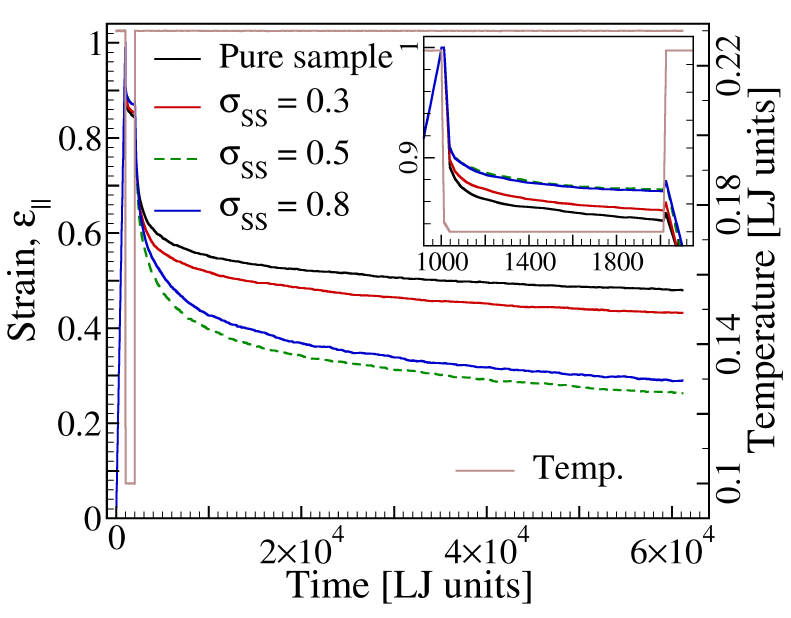
Figure 7. Additive size effect on shape recovery. The plot shows strain versus time in a shape memory cycle for a pure polymer and polymer-additive mixtures at φ s = 0.20 for three choices of additive’s diameter, σ SS , as indicated. The recovery temperature is T recovery = 0.23. A close scrutiny of the data reveals a non-monotonic dependence of the shape recovery process on particle size, the largest recovery occurring for the sample with σ SS =